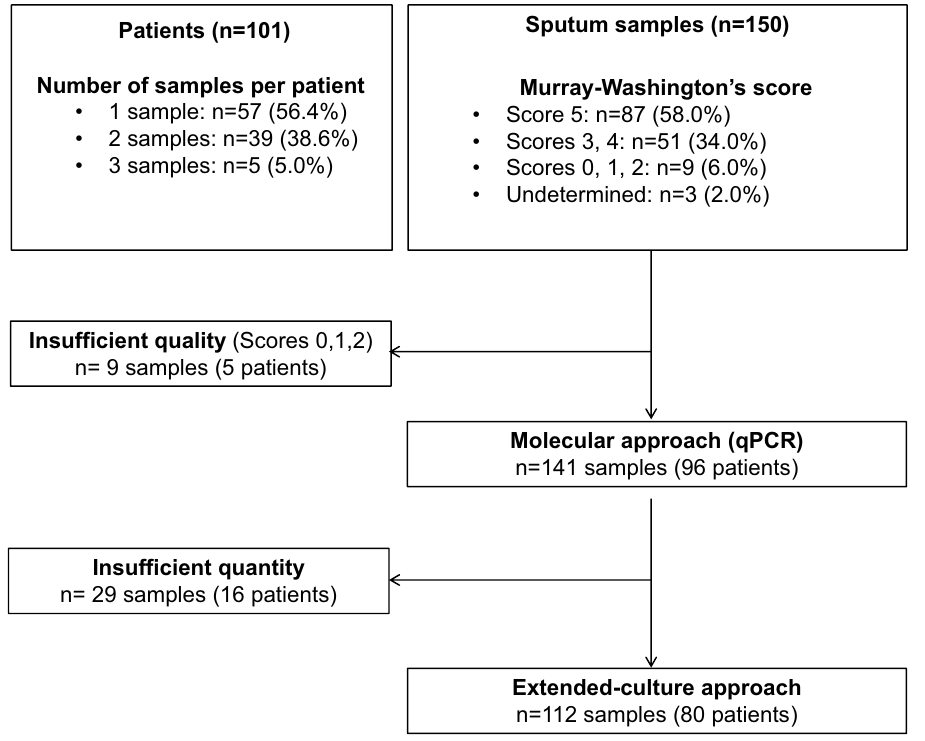
Figure 1. Flow chart of the patients and samples included in the